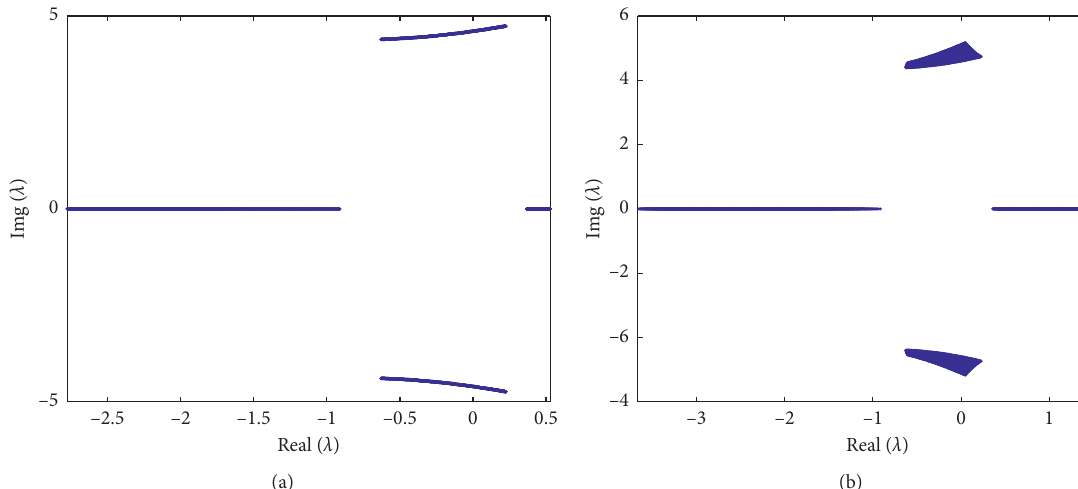
Figure 2: Representation of eigenvalue locus in the complex plan ( Re ( λ ) , Im ( λ )) with the following parameter values: (a) a � 1 . 8, b � 3 . 8, c � 2 . 442, d � 1 . 35, e � 14 . 85, and 2 ≤ m ≤ 10; (b) a � 1 . 8, b � 3 . 8, d � 1 . 35, e � 14 . 85, 2 ≤ m ≤ 10, and 2 . 34 ≤ c ≤ 12 . 985. The appearance of eigenvalues in complex conjugate pairs justifies the symmetry observed in the system and intersection of the curve with imaginary axis shows the presence of the Hopf bifurcation in the system.